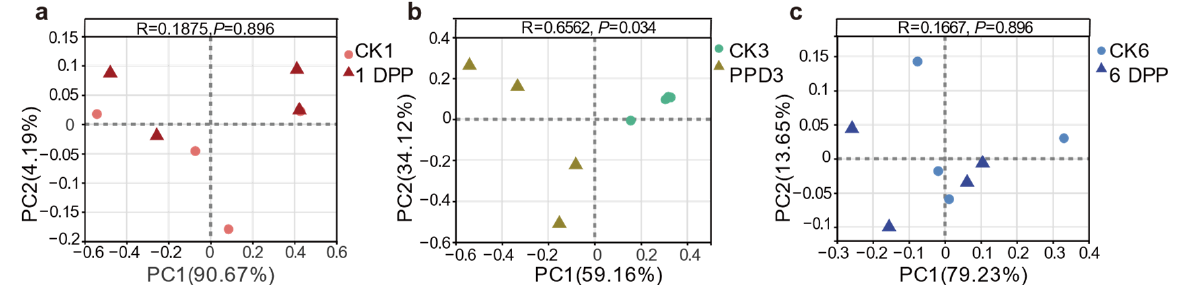
Figure 2. Alpha diversity of the host gut microbiome in the parasitized (CK1, CK3, CK6) and non-parasitized (1 DPP, 3 DPP, 6 DPP) groups at the OTU level. ( a ) Rarefaction curves based on Sobs values (the observed richness); ( b , c ) Violin plot showing sobs and Shannon values of bacterial communities in different samples. Wilcoxon rank-sum test between two independent samples was performed among treatments. The symbol “*” indicates statistically significant differences between the two groups being compared ( p < 0.05).